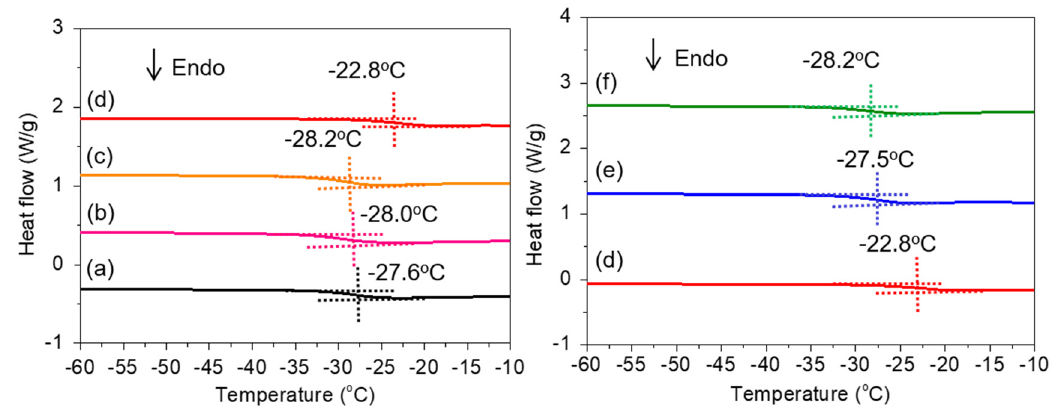
Figure 3. DSC heating curves of PGS ( a ), PGSE1 ( b ), PGSE2 ( c ), PGSE3 ( d ), PGSE-B ( e ), and PGSE-Z ( f ).